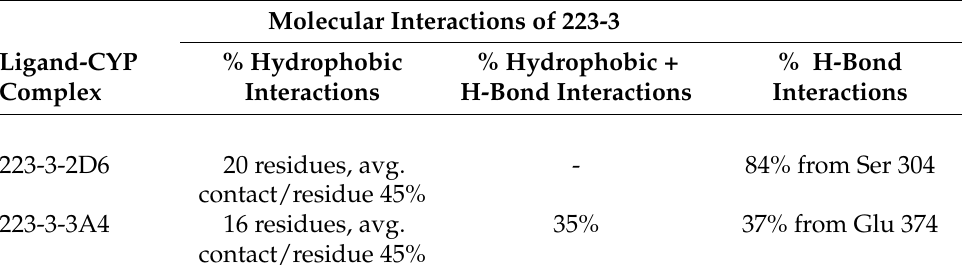
Table 2. Molecular interactions of 223-3 with active site residues of representative